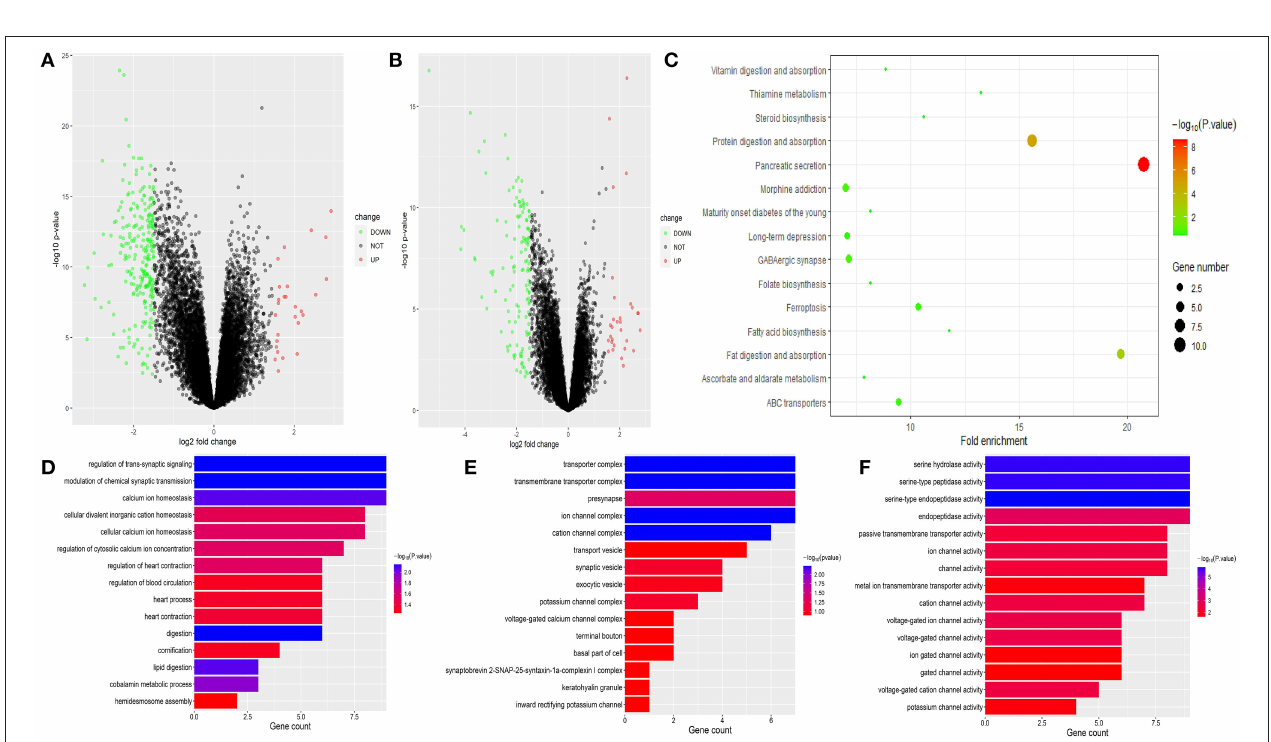
FIGURE 8 | Volcanic map based on differential gene expressions of TCGA (A) and ICGC. (B) KEGG pathway analysis of DEGs. Only pathways with a P -value< 0.05 are presented. (C) GO analysis of DEGs in PC Biological process, cell components, and molecular function enrichment analyses of DEGs (D–F) .